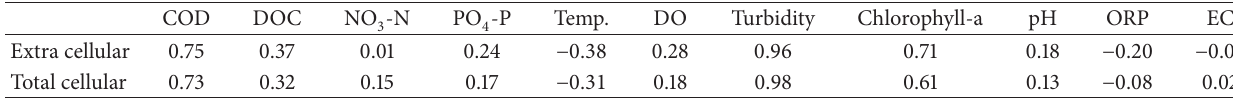
Table 1: Correlation coefficients for each parameter.